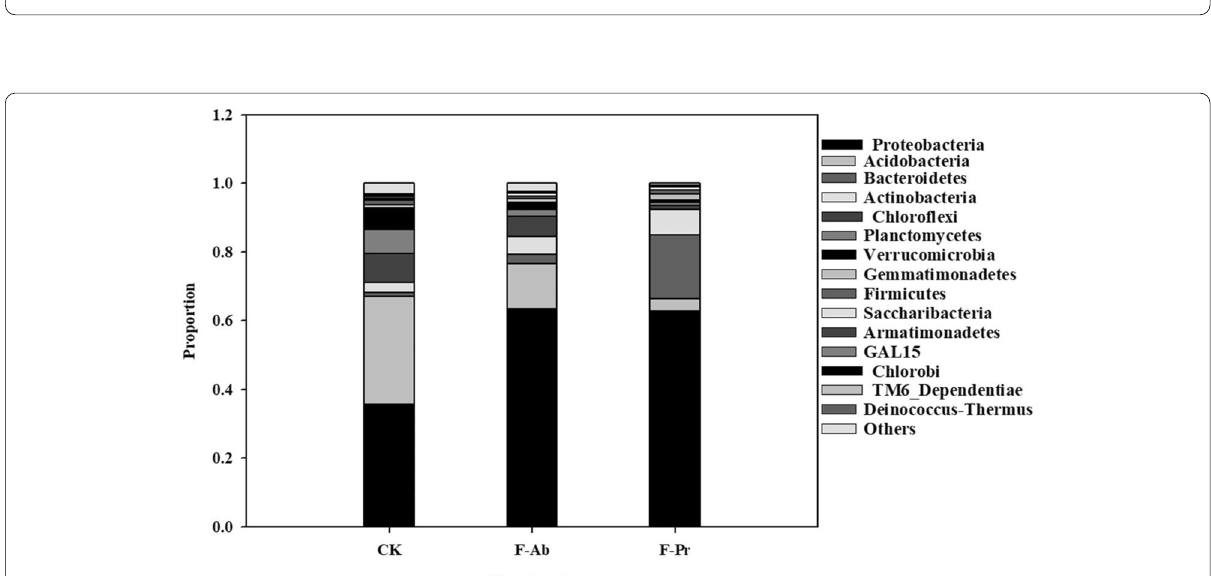
Fig. 3 The relative abundance of phyla of soil microbiome in tea plantation across all the plots covered with Litsea cubeba plots (% of total sequence). CK, control; F‑Ab, the vegetative branches cover treatment; F‑Pr, the fruit‑bearing branches cover